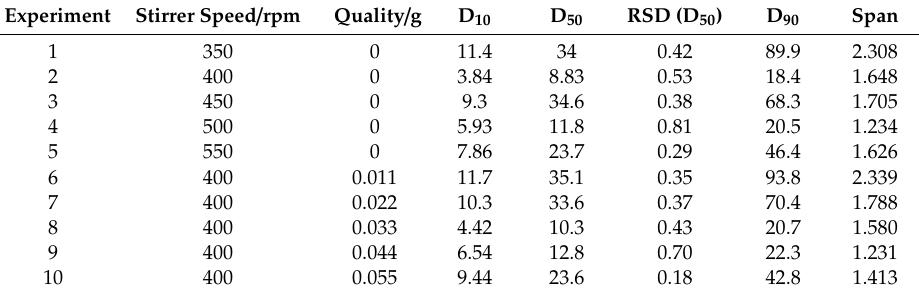
Figure 17. Effect of stirrer speed and seeds on CSD by ( a ) different stirrer speed and ( b ) different Figure 17. E ff ect of stirrer speed and seeds on CSD by ( a ) di ff erent stirrer speed and ( b ) di ff erent quality quality of crystal seeds, respectively. of crystal seeds, respectively. Table 2. CSD of LCZ696 crystals obtained in experiments Table 2. CSD of LCZ696 crystals obtained in experiments 1~10.